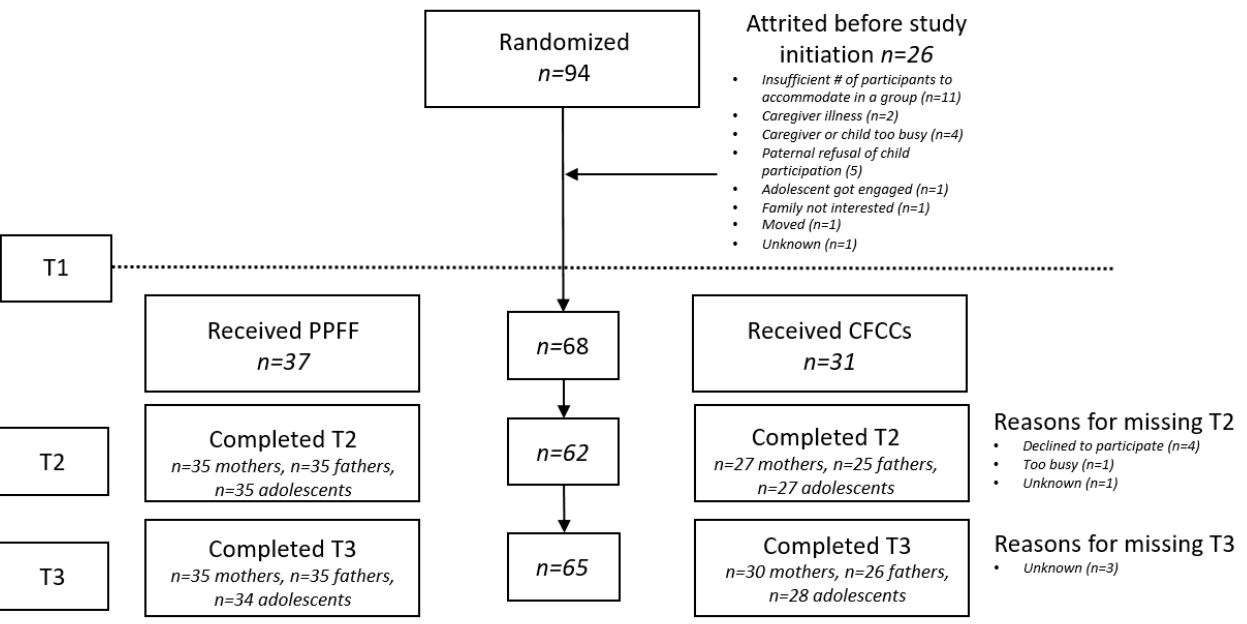
Figure 1. CONSORT Figure 1. CONSORT Diagram.